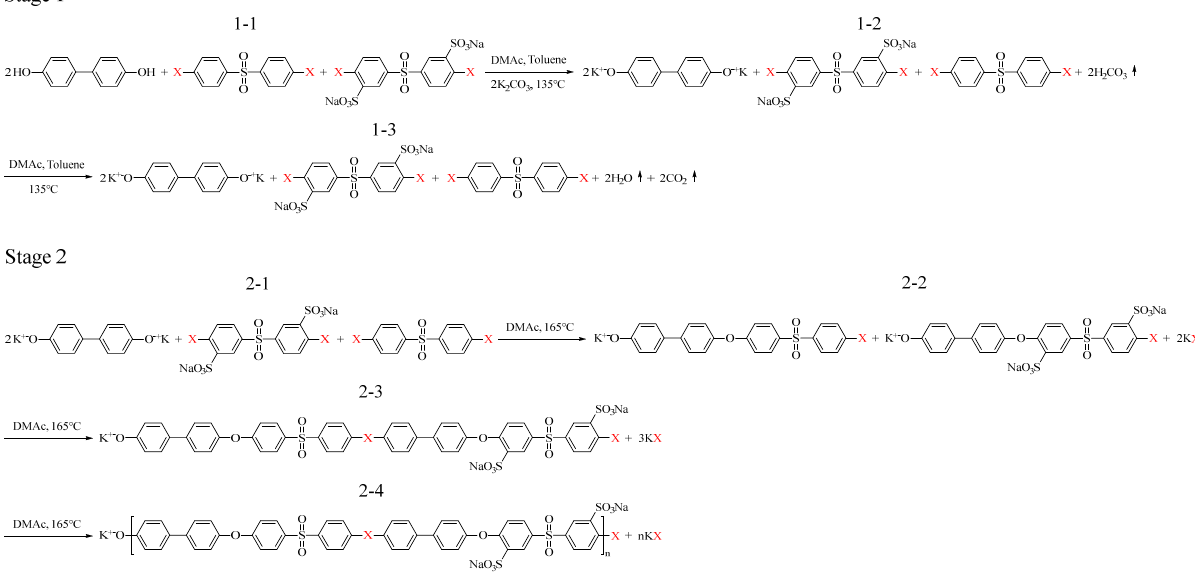
Figure 6. Structural optimization process of one repeating unit of the SPAES copolymer. The Gibbs free energy change can be obtained by calculating the chemical potential for the SPAES polymer and salts since it was assumed to be in a solid phase minimizing the en ‐ tropy effect. The chemical potential was obtained using the equation shown in Figure 7 for each step. Given this, salts were assumed to be in a solid state, and other compounds were assumed to be in a gaseous state. To find a stable structure, we tried to calculate by considering the possible structures with flat and distorted models (Figures S1 and S2).